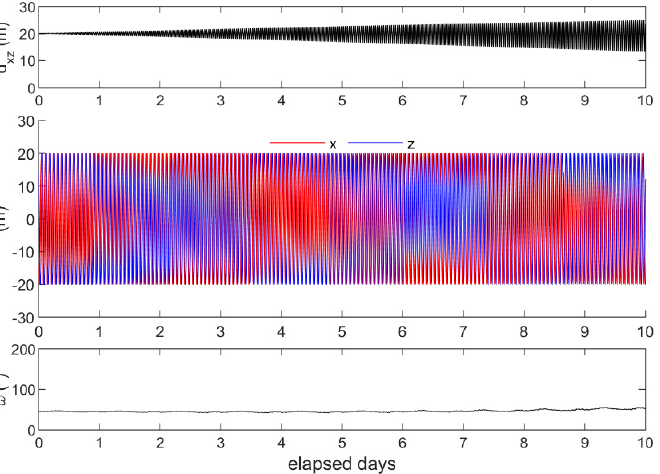
Figure 3. Two spacecraft Sun-synchronous formation based on safety tubes: h = 550 km, d xz = A x = A z = 20 m. Evolution of d xz , x , z , and ω for the first ten days of mission.